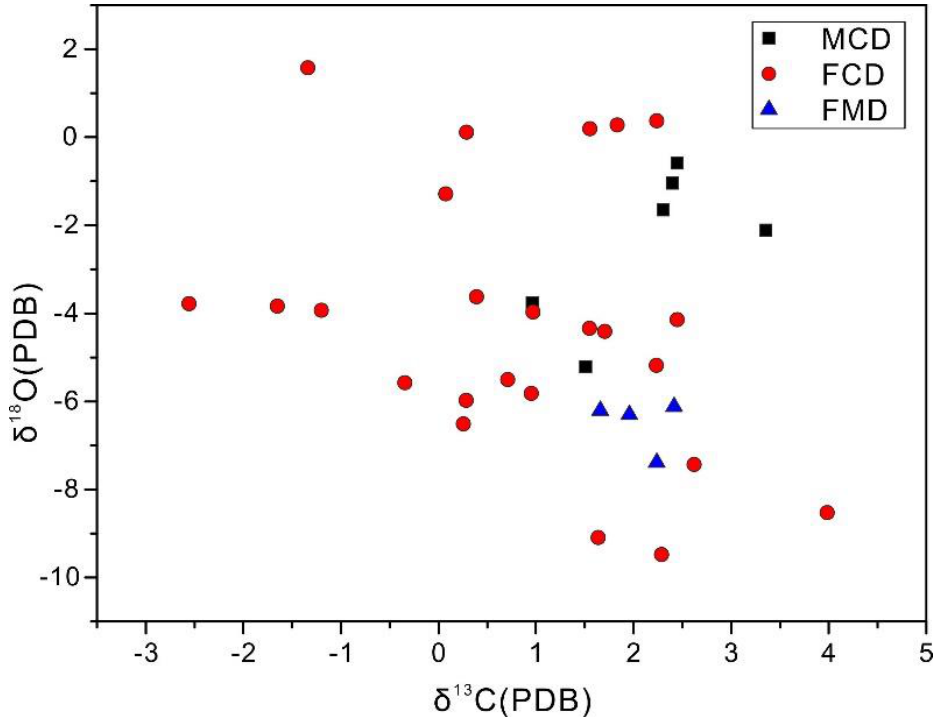
Figure 7. Cross−plot of δ 13 C and δ 18 O values for dolomites. FMD: Fine-microcrystalline dolomite; FCD: Fine crystalline dolomite; MCD: Medium crystalline dolomite.